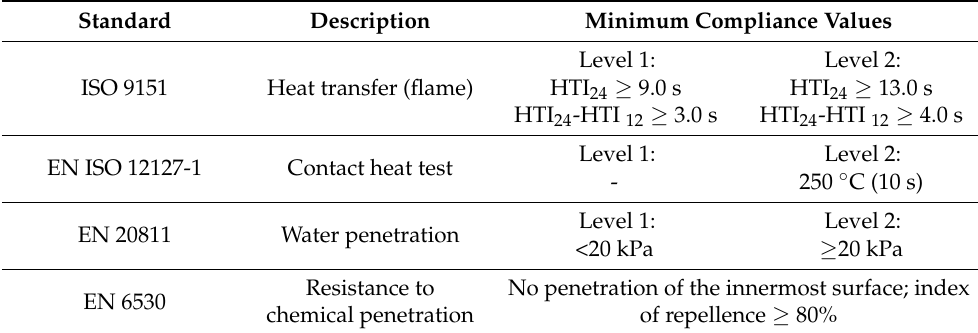
Table 2. Specific required tests and minimum compliance values for structural firefighting protective clothing.